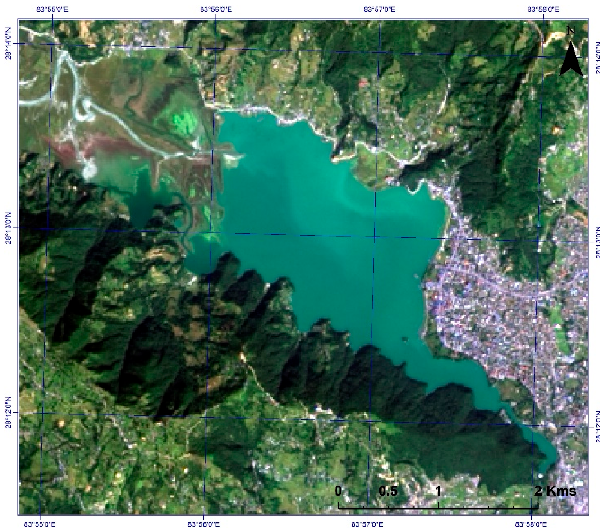
Figure 1. The geographical locations of study area: Phewa Lake in Pokhara,